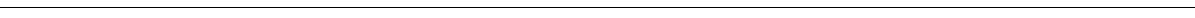
Figure 3 | RC-seq reveals endogenous de novo L1, Alu and SVA retrotransposition in pluripotent stem cells. ( a ) Structures of validated de novo L1, Alu and SVA retrotransposition events (red box, untranslated region; white box, L1 ORF; green diamonds, TSDs). Names of insertions (for example, L1-dn10), and gene (for example, SLC12A1 ) or chromosomal positions for intergenic insertions are listed. RC-seq reads are aligned above the insertions (red/white bars). Nucleotide positions at 5 0 ends of L1 and Alu insertions refer to L1.3 and Alu Yb8 reference sequences, respectively. Corresponding validation PCRs are presented on the right. a and b , validation primers. ( b ) Relative L1-dn13 and L1-dn14 copy numbers at hiPS-SB4 passages 43 and 53 were determined by qPCR. Binding sites of the TaqMan primer/probe combinations specific for the 5 0 junctions of insertions L1-dn13 or L1-dn14 are shown (Top panels, red arrows and lines). Genomic DNAs from parental HFF-1 cells, and HES-3 cells served as negative controls. For normalization, a primer/probe combination specific for the human single-copy gene RPP25 was used. DD Ct values measured the relative L1-dn13 and L1-dn14 insertion content, respectively, normalized to the parental cell line HFF-1. Bars, arithmetic means ± s.e.m. of technical triplicates. Due to the minimal s.e.m. observed in the L1-dn14-specific qPCR (right panel), error bars are not visible. ( c ) Passaging scheme of the hiPS-SB4 line harbouring L1-dn13. After reprogramming of HFF-1 cells into the hiPS-SB4 line, hiPSCs were cultivated for 60 passages (culture 1). Genomic DNA (gDNA) was isolated from culture 1 at passages shown in red. Cells of passage 19 were split and half of the culture was cryo-preserved and cultivated again after several weeks of cryo-preservation (culture 2). gDNA was isolated from passages shown in blue. ( d ) Relative L1-dn13 content at passages 43, 56, 58 and 60 of culture 1 (red lettering) and at passages 28, 34, 43 and 49 of culture 2 (blue